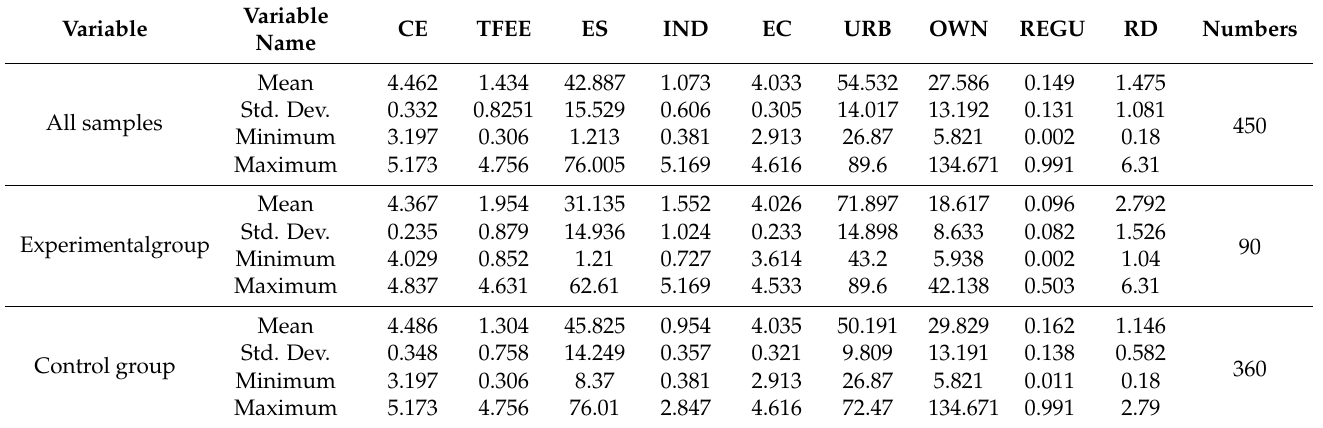
Table 1. Descriptive statistics of the